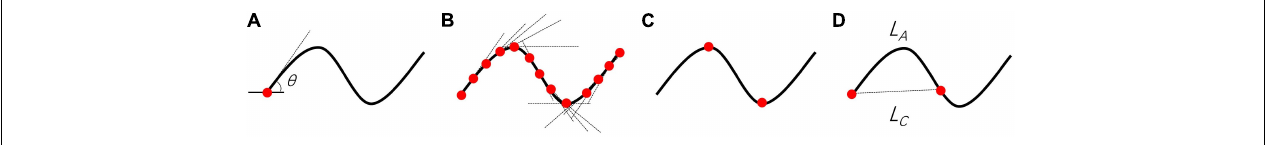
FIGURE 2 | Visual demonstration of parameters required for VTI computation. (A) θ is the angle between lines tangent to each centerline pixel and the x -axis. (B) Tangent lines for points along the centerline. (C) N is the number of critical points where the first derivative of the centerline vanishes. The critical points (red circles) were determined based on changes in the sign of slope of the tangent lines. (D) L A and L C are the length of the centerline and its chord, respectively. The magnitude ( M ) of the curve is the ratio of L A to L C between pairs of inflection points including centerline